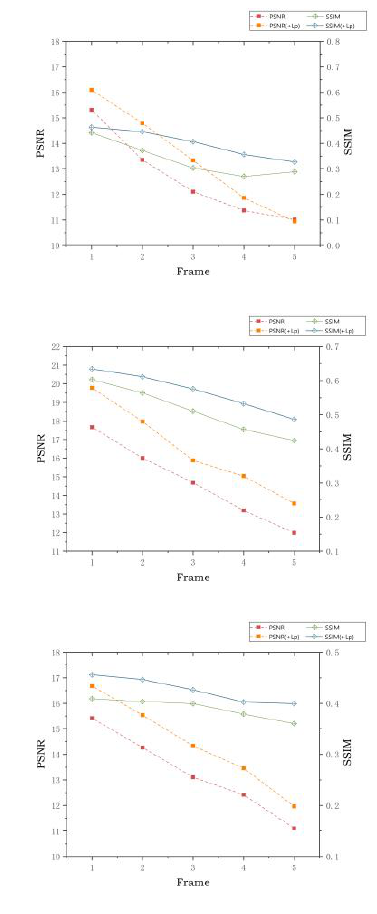
Figure 5. Subsequent PSNR and SSIM line charts at multiple